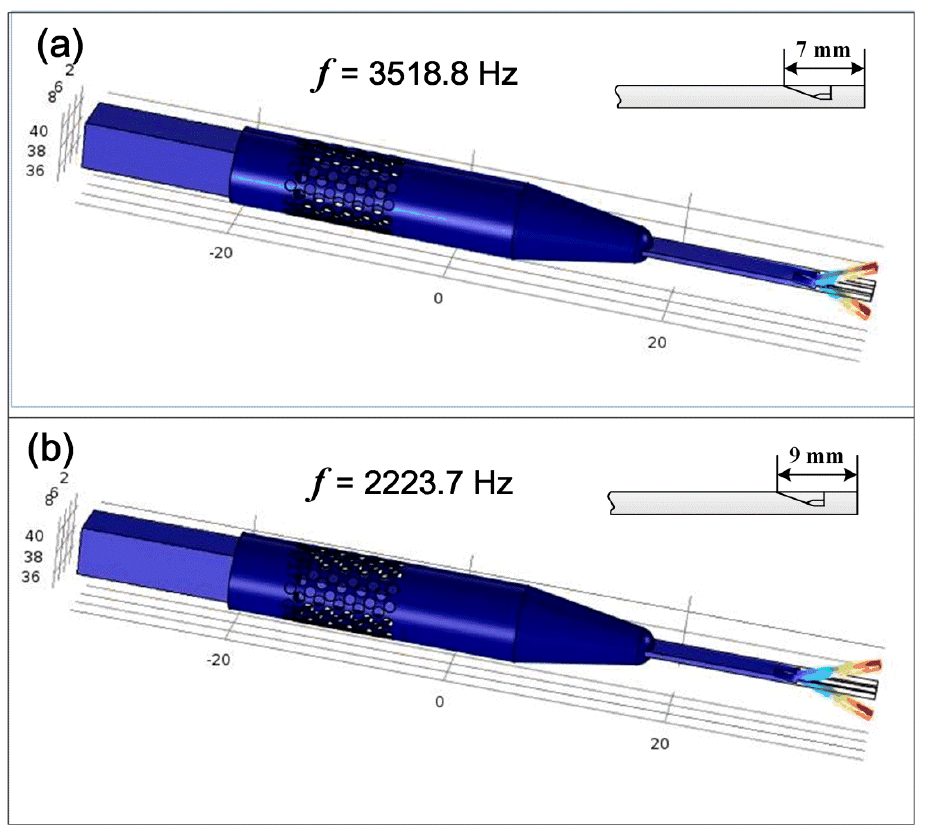
Figure 3. FEM simulation results of ( a ) Eigen frequency and mode shape with 7 mm beam tip; ( b ) Eigen frequency and mode shape with 9 mm beam tip.